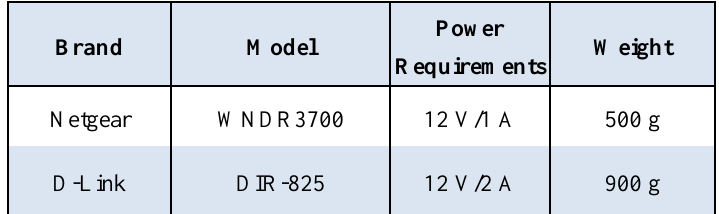
Table 3. Weight and energy requirements